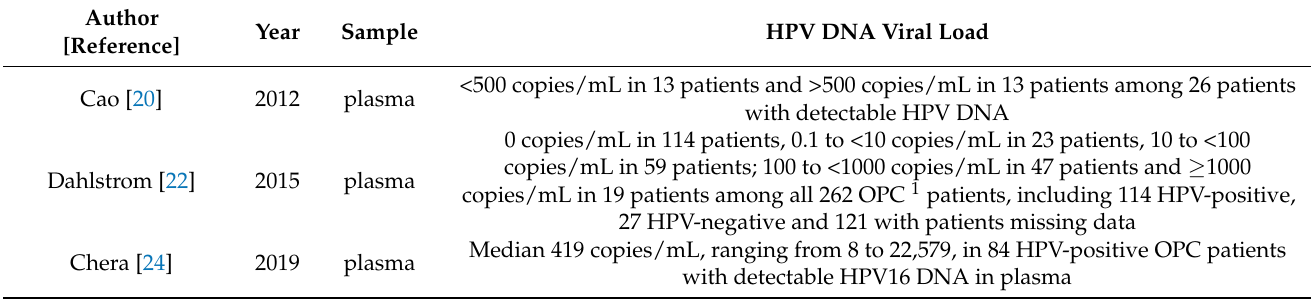
Table 2. HPV DNA viral load in pre-treatment plasma in oropharyngeal cancer